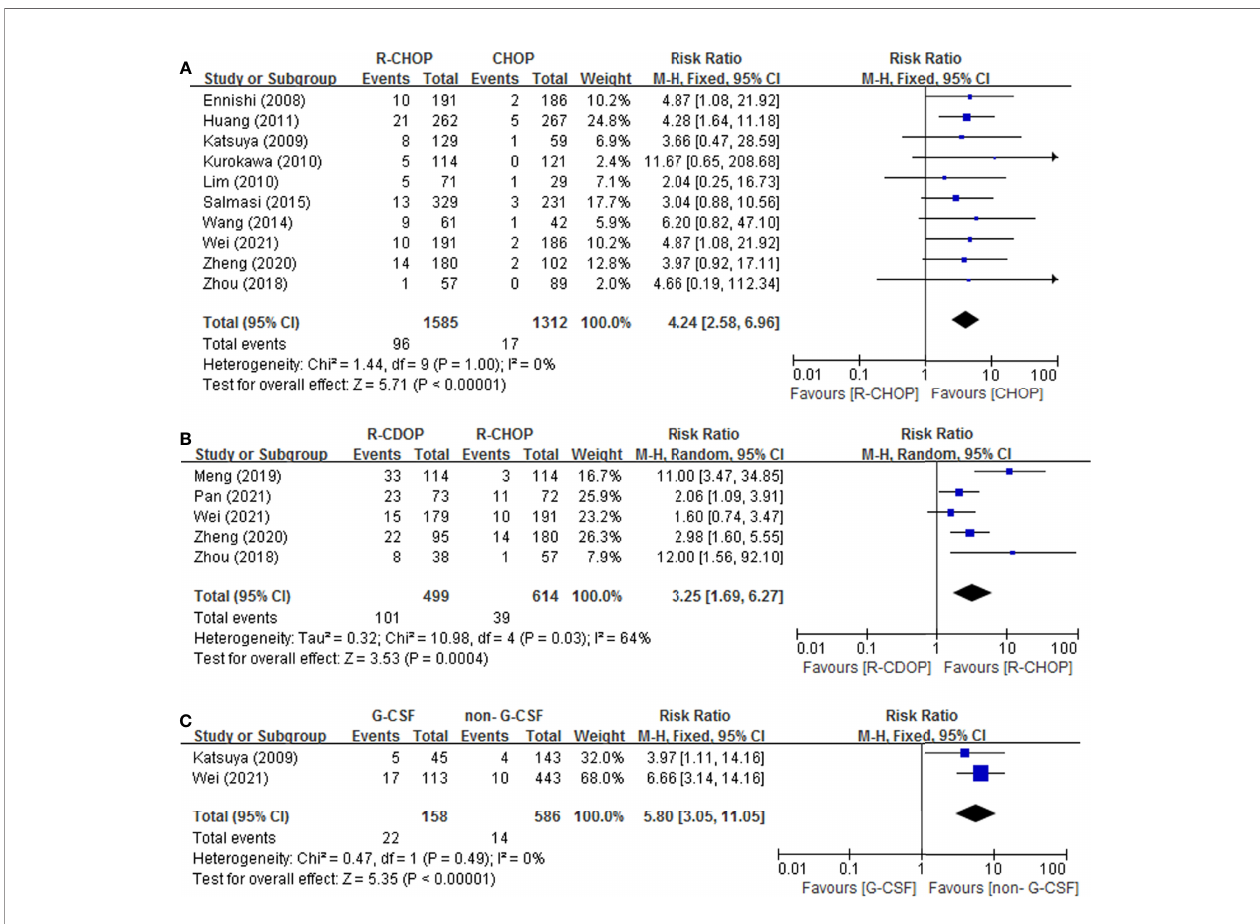
FIGURE 4 | Forest plot of studies among drug-related risk factors associated with IP development. (A) RTX. (B) PLD. (C) G-CSF.